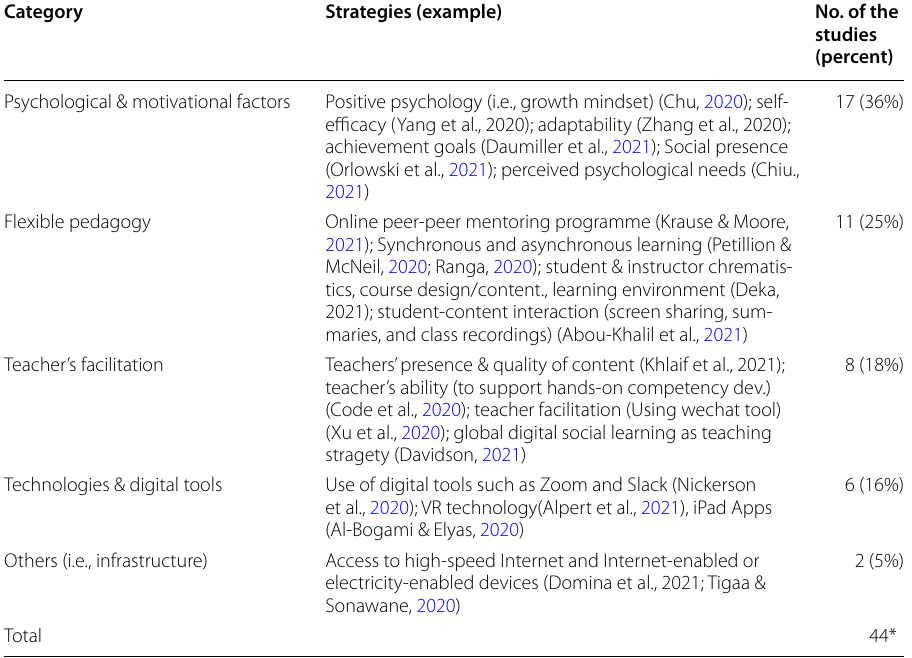
*In four studies, at least two categories of strategies were applied simultaneously